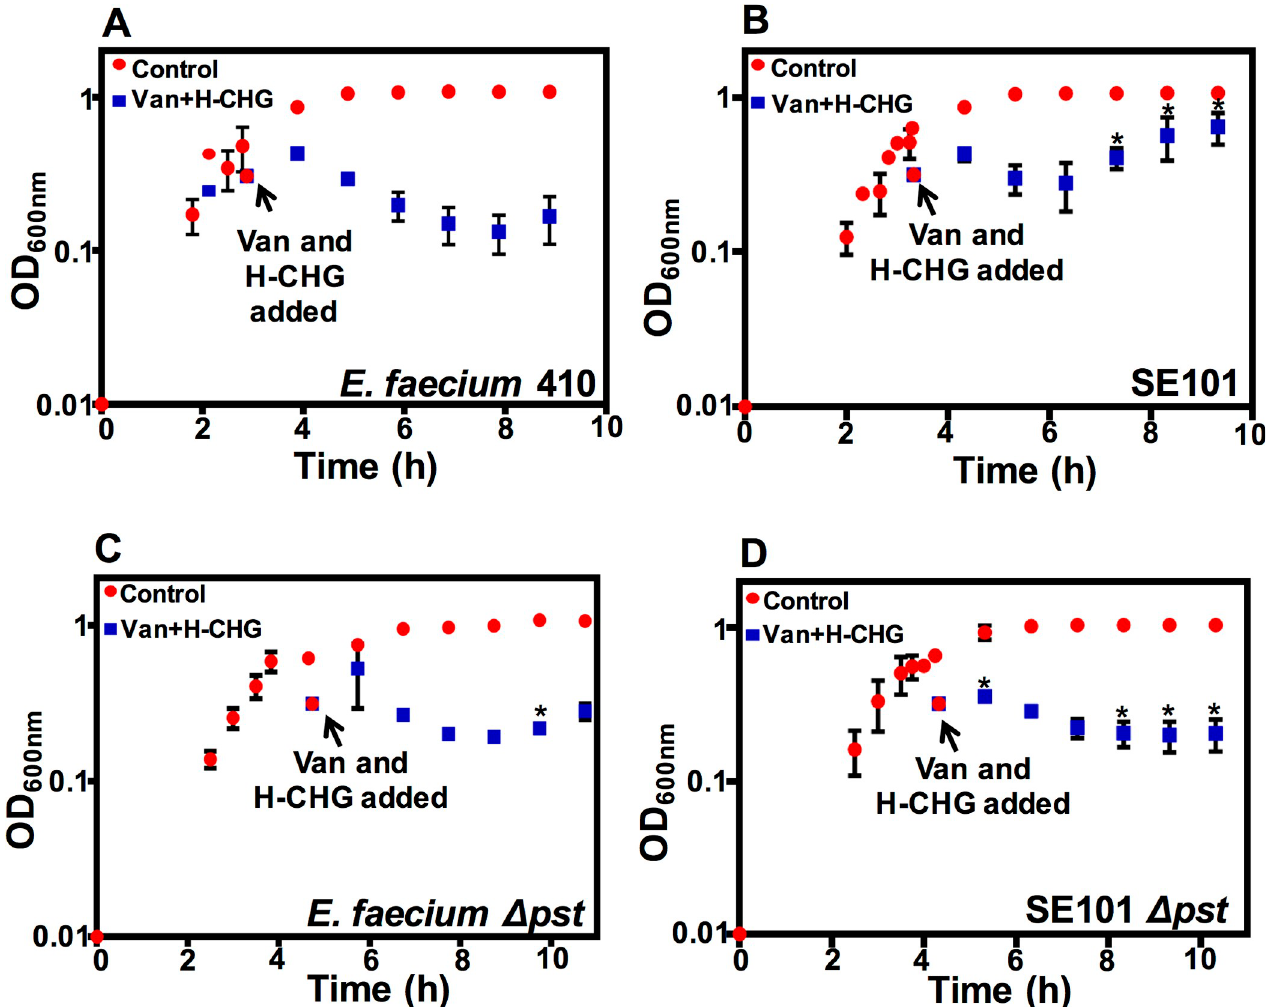
Fig 4. Mutations in the phosphate-specific transport ( pst ) operon result in escape from vancomycin and H-CHG synergy. Growth of (A) E . faecium 410 wild-type, (B) SE101, (C) E . faecium 410 Δ pst , and (D) SE101 Δ pst . E . faecium was cultured in BHI until the OD 600 reached 0.6. Equal volumes of cultures were split into BHI (control; red circles) or BHI containing vancomycin (50 μ g/ml) and H-CHG (4.9 μ g/ml) (blue squares). OD 600 values were monitored for 6 h and the 24 h time point was recorded. Error bars indicate standard deviations from n = 3 independent experiments. Significance was assessed using the one-tailed Student’s t -test. � denotes P -value < 0.05. Stars indicate significant differences between vancomycin- and H-CHG-treated cultures in panel B versus A, in panel C versus A, and in panel D versus